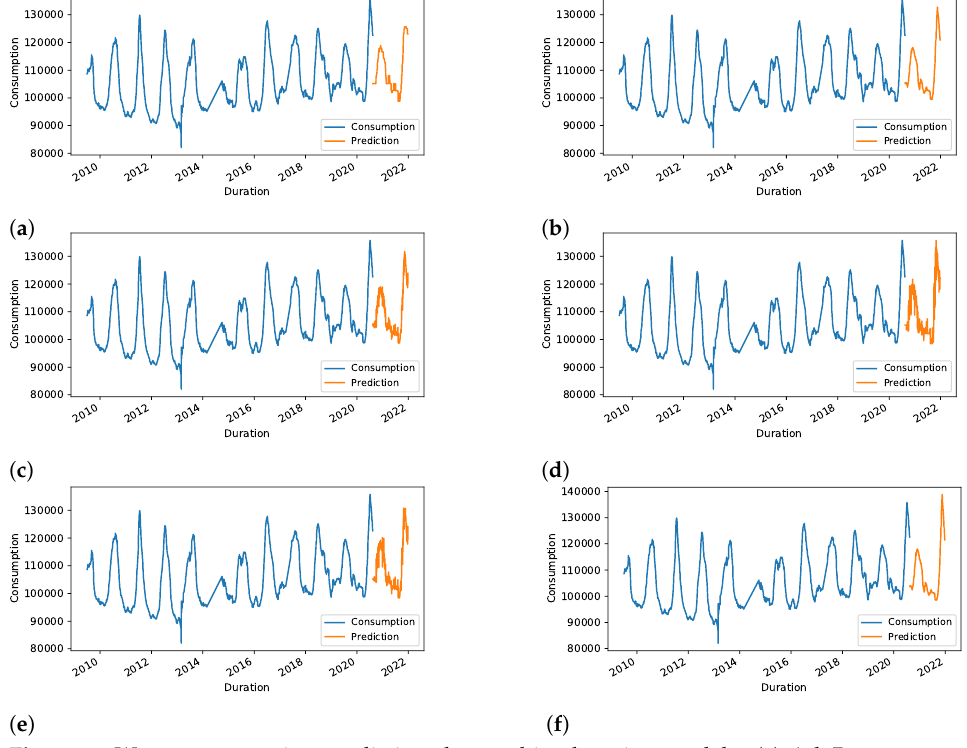
Figure 8. Water consumption predictions by machine learning models: ( a ) AdaBoost regressor; ( b ) linear regressor; ( c ) extra tree regressor; ( d ) decision tree regressor; ( e ) random forest regressor; and ( f ) support vector